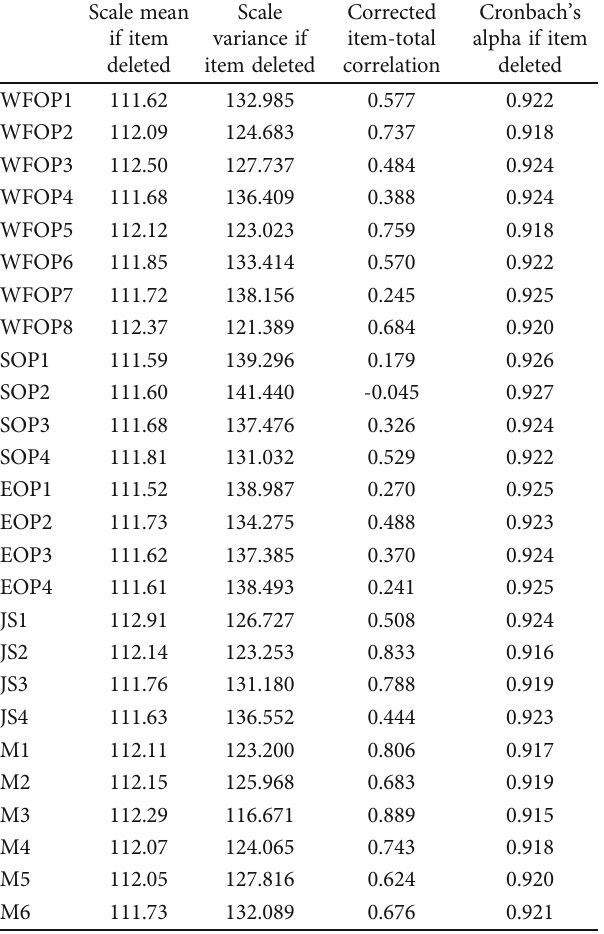
Table 8: Item-total statistics for all variables.